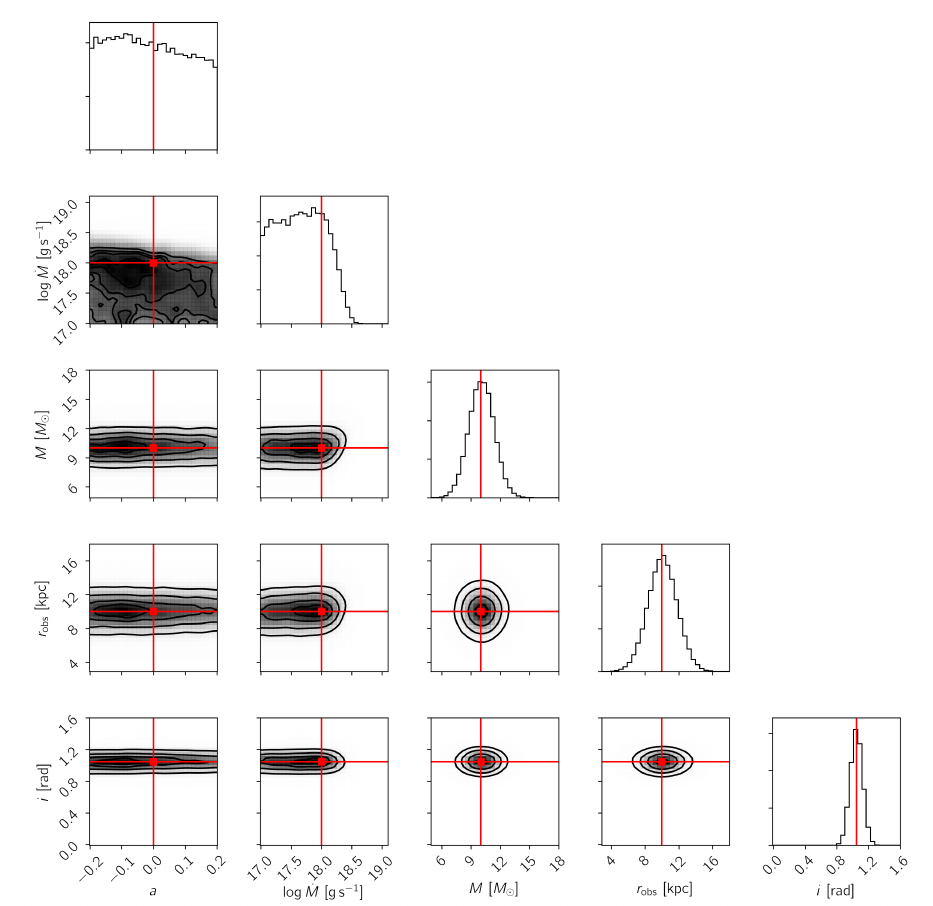
Figure 1. Results of the MCMC analysis for case A, where the vertical lines correspond to the injected values. The parameters M , r and i are well constrained, mainly because of the Gaussian priors used. However, obs the parameters a and ˙ M are not well estimated due to the large degeneracies between these two